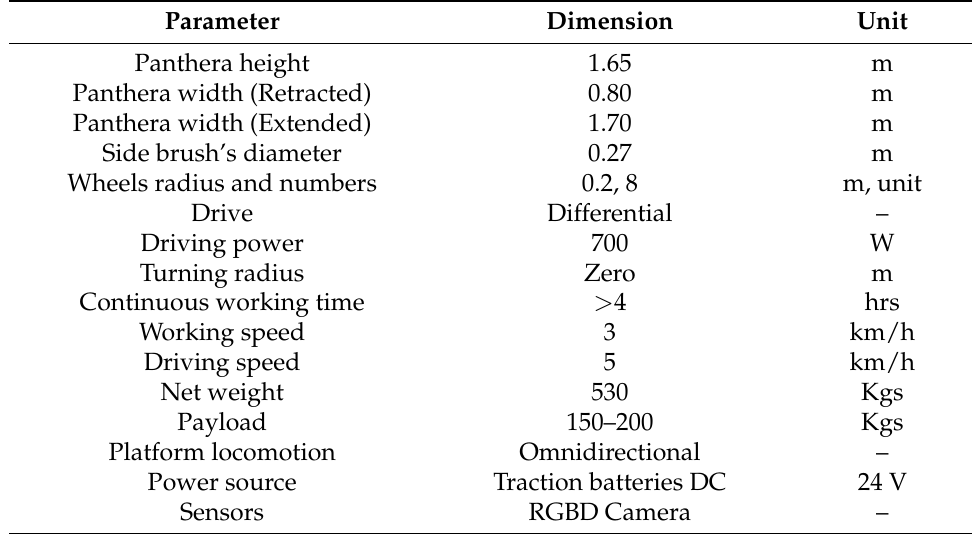
Figure 1. Self-reconfigurable pavement inspection and cleaning robot Panthera. Table 1. Panthera